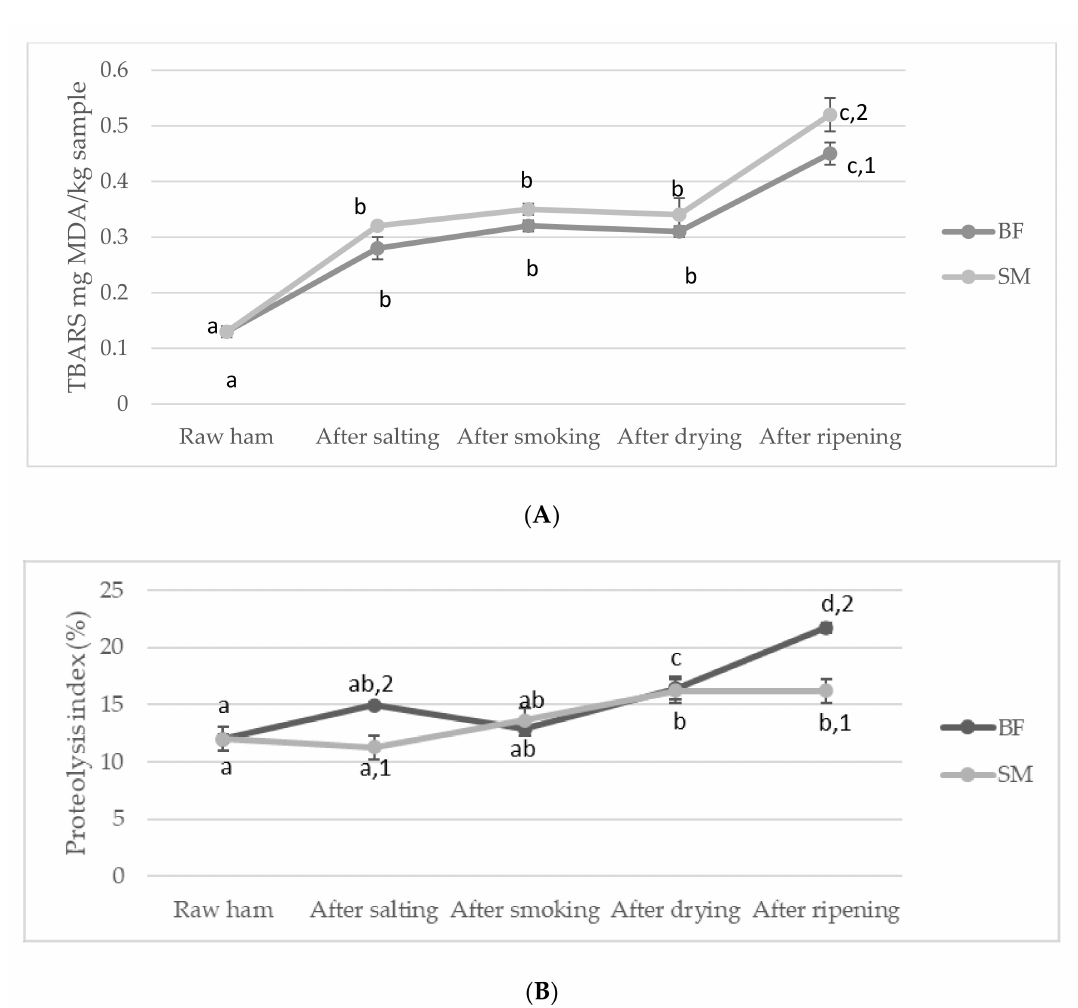
Figure 1. Evolution of lipid oxidation and proteolysis in BF and SM muscles during the production process of smoked dry-cured ham (mean ± standard error): ( A ) Thiobarbituric acid reactive substances (TBARS) index and ( B ) proteolysis index. Different letters (a–d) denote statistically different results ( p < 0.05; Tukey test) (differences between production stages) while different numbers (1–2) denote statistically different results ( p < 0.05; Student t -test) (differences between